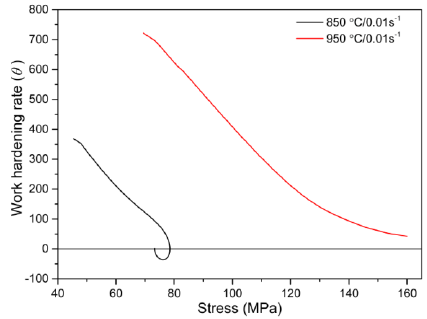
Figure 8. The dependence of work hardening rate on the stress at 0.01 s −1 and at different temperatures (850 °C and 950 °C).